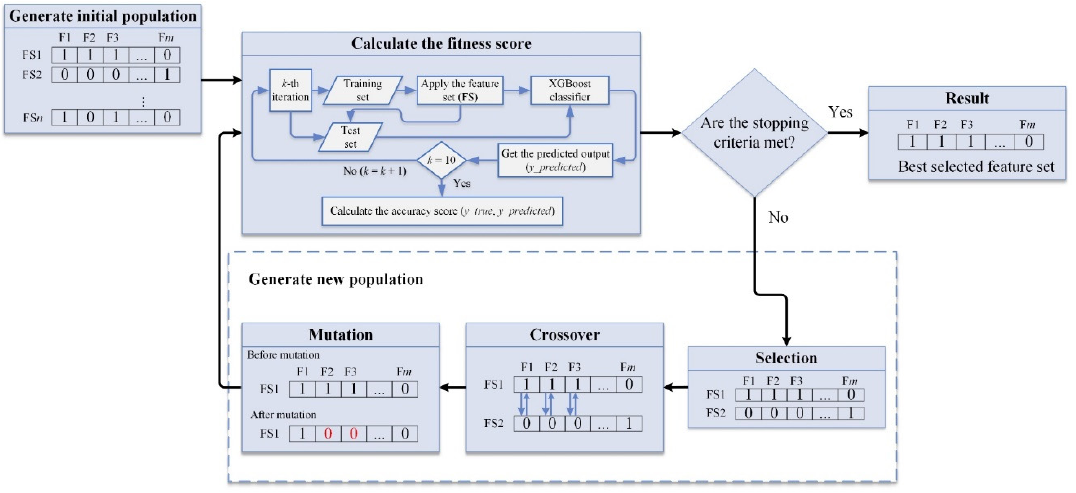
Figure 2. The flow-chart of genetic algorithms (GA)-based feature selection. Algorithm 1. Genetic Algorithms (GA)-based feature selection pseudocode